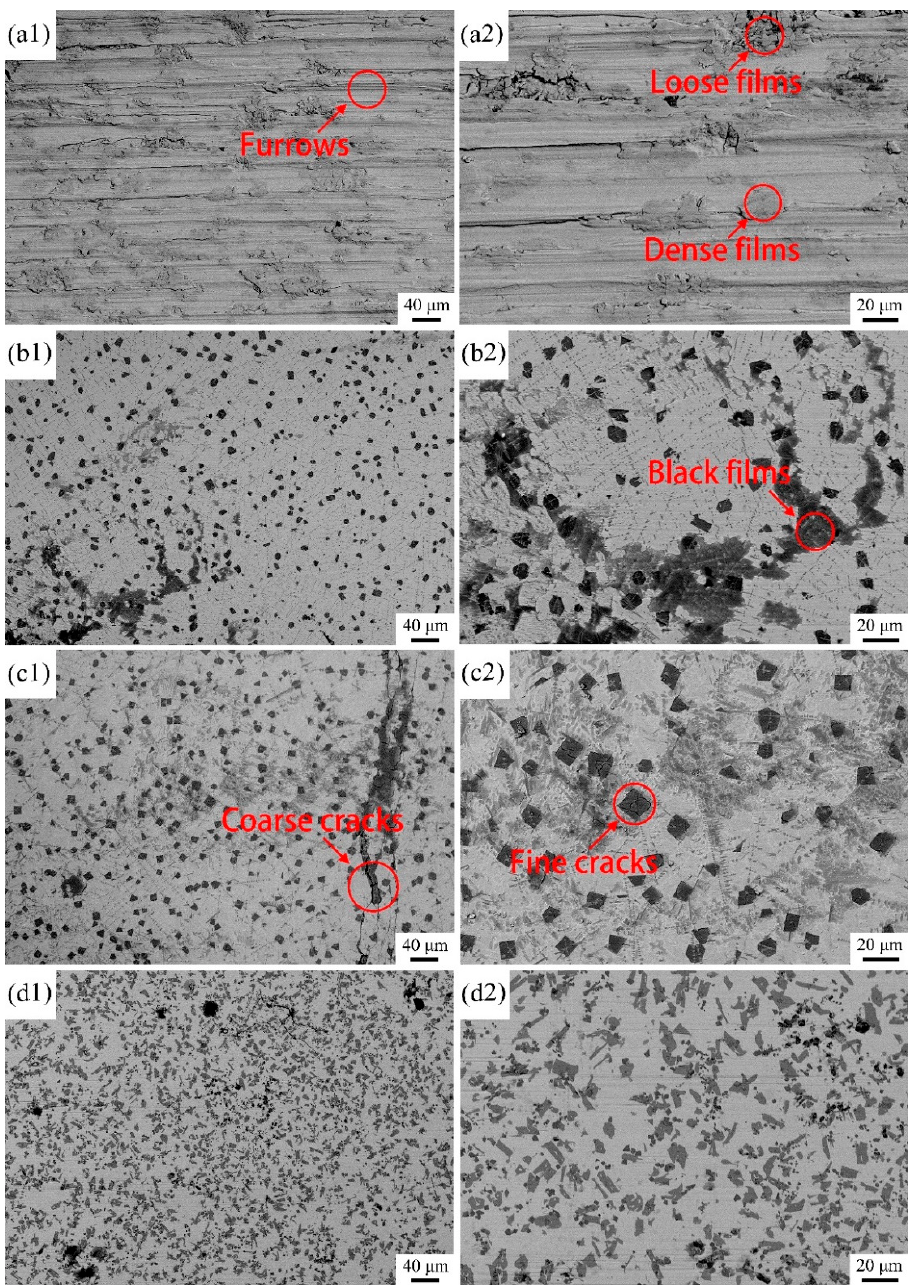
Figure 10. BSE images of the worn morphologies of the samples: ( a1 , a2 ) substrate; ( b1 , b2 ) Coating 1 for 5 mm ∙ s − 1 ; ( c1 , c2 ) Coating 2 for 11 mm ∙ s − 1 ; ( d1 , d2 ) Coating 3 for 17 mm ∙ s − 1 .